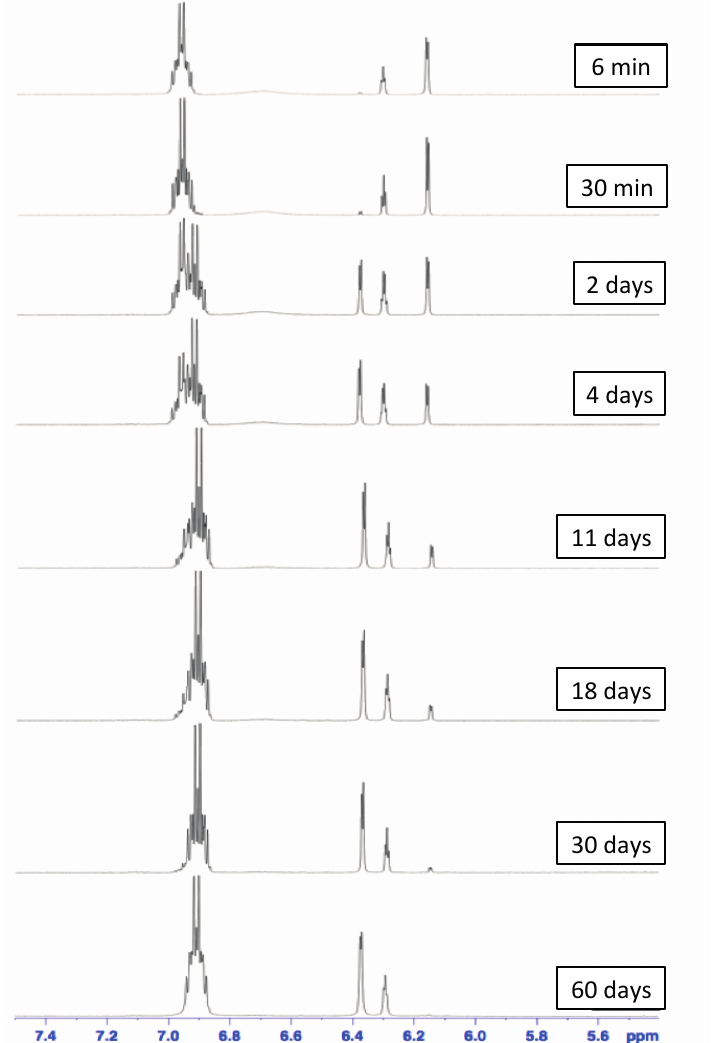
Figure 4. Partial 1 H NMR spectra (400 MHz, CD 3 CN, 298 K) showing the extrusion of DB24C8 macrocycle from the isolated [2]pseudorotaxane DB24C8 ⊃ 1 -H·PF 6 with excess triethylamine (TEA)/diisopropylethylamine (DIPEA) mixture in CD 3 CN over